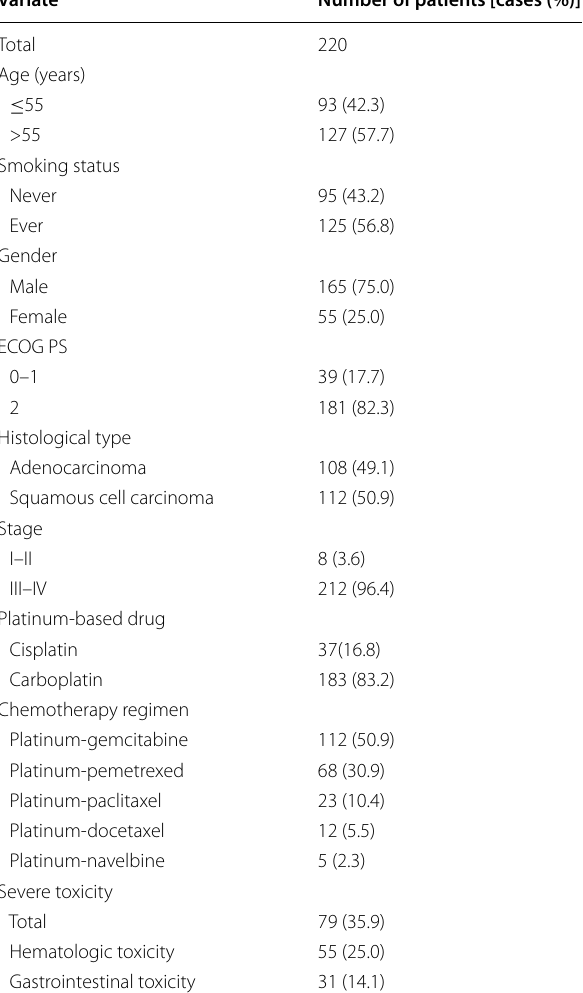
Table 2 The clinical characteristics of the 220 non-small cell lung cancer (NSCLC)